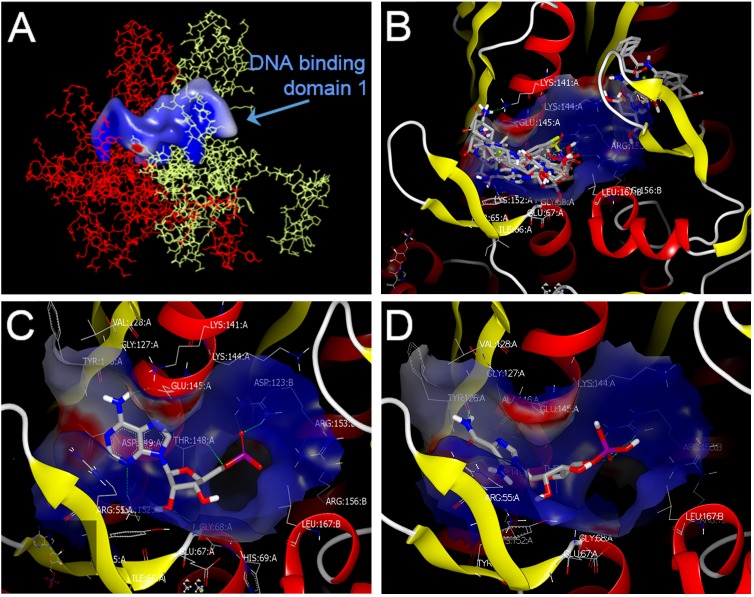
Modeling of the interaction between RAD52 DNA binding domain 1 and candidate inhibitory compounds.(A) The DNA binding site 1 of RAD52 as identified by OEDocking (Openeye). The continuous channel of DNA binding site 1 as formed by adjacent monomers in red and yellow. (B) Proposed “hotspots” for binding of the 9 “confirmed hits” in DNA binding domain 1. These “hits” were docked to the DNA binding domain 1 of a RAD52 dimer using OEDocking (Openeye) to establish a docking model. (C,D) The predicted binding mode of the RAD52 primary DNA binding site 1 using the docked ligands: A5MP (C) and AICAR 5’-phosphate (ZMP) (D).